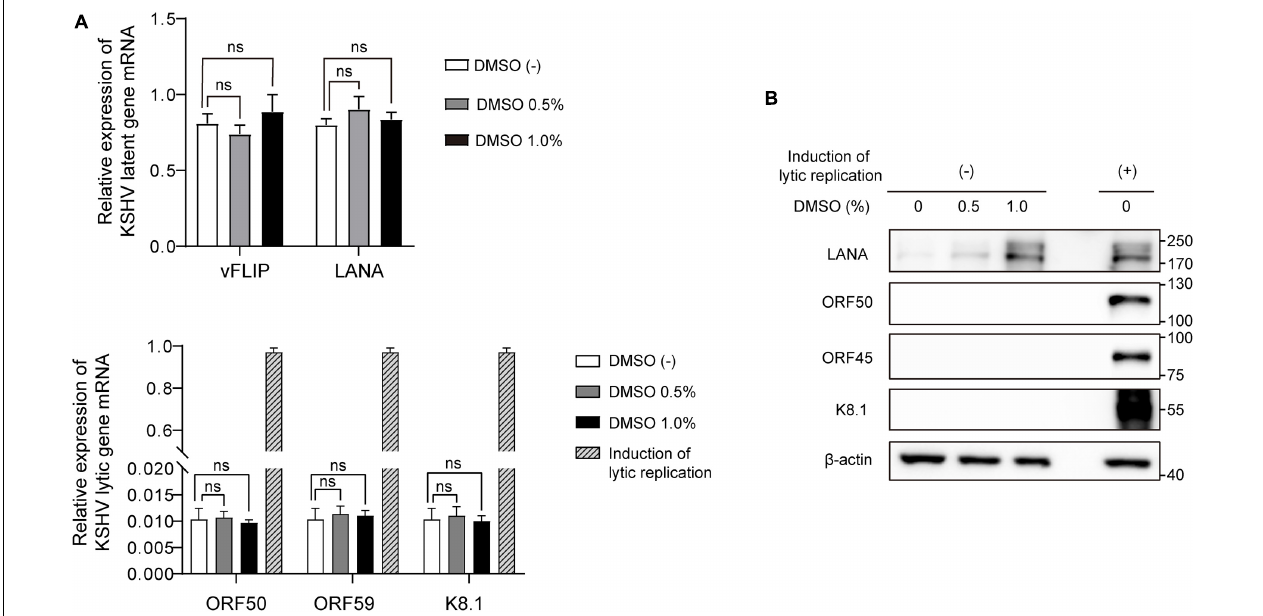
FIGURE 6 | Differential expression of viral genes induced by DMSO during latent KSHV infection. iSLK BAC16 cells were treated with various concentrations of DMSO for 24 h. Next, total RNA and protein were isolated to analyze viral gene expression. (A) RT-qPCR analysis of mRNA expression of KSHV viral genes. Data are shown as the mean ± SD, n = 3, and ns, not significant. (B) Western blot analysis of the indicated viral proteins in iSLK BAC16 with (+) or without induction of lytic replication (–).